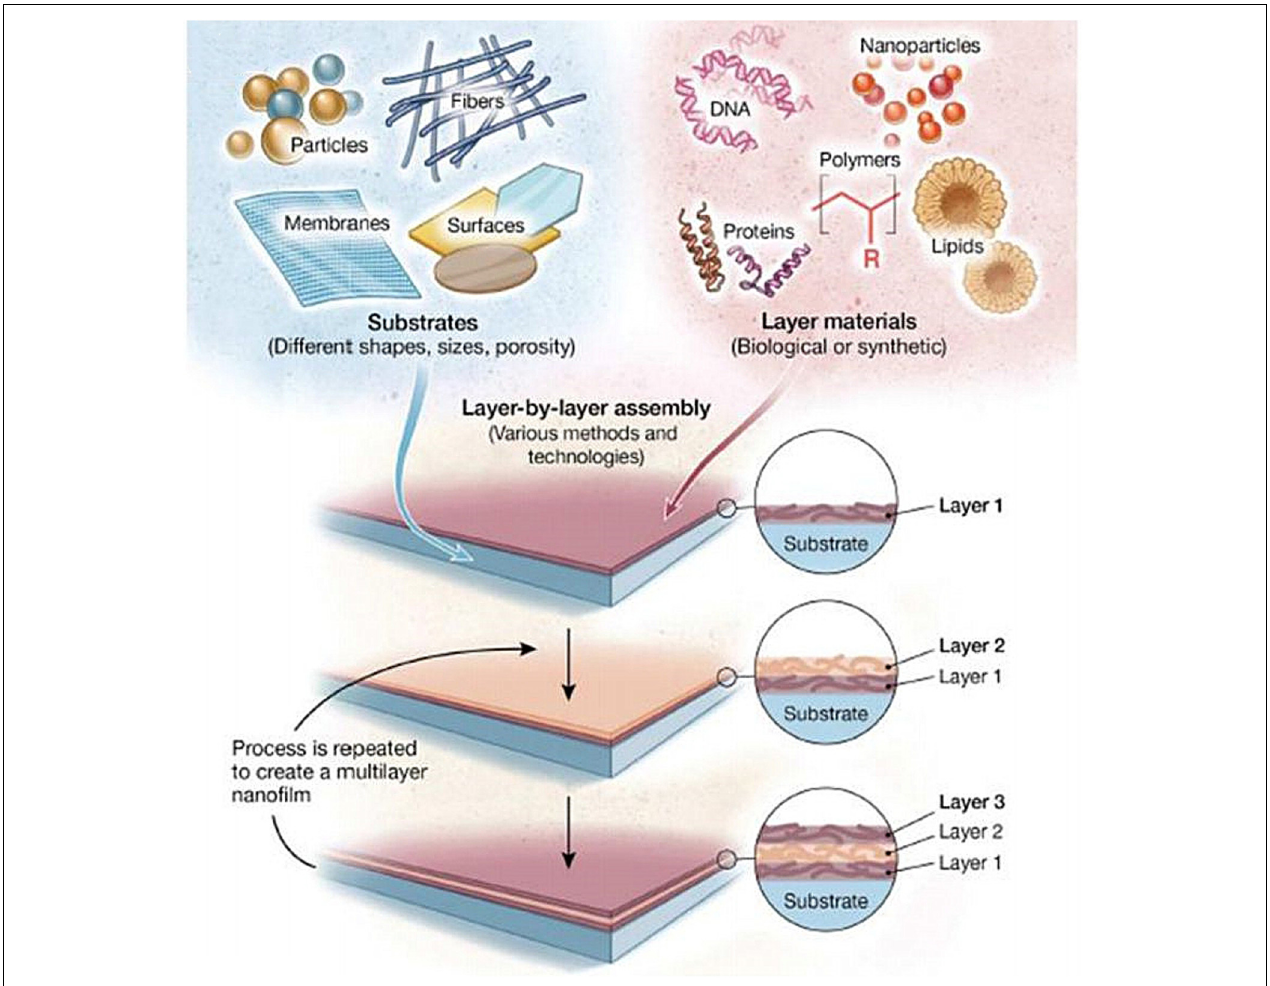
FIGURE 5 | Schematic illustration of LbL assembly technology, which can load different types of materials on different types of substrates (Zhang et al.,